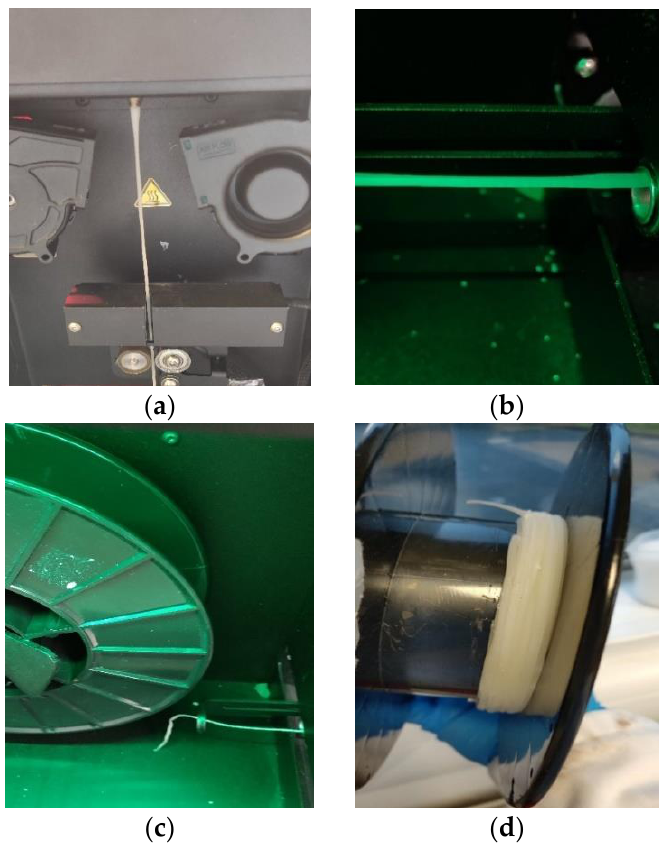
Figure 4. Most frequent filament production deformities occurring during the process: ( a ) inconsistent diameter; ( b ) filament flat or oval; ( c ) breakable filament; ( d ) filament clotting.